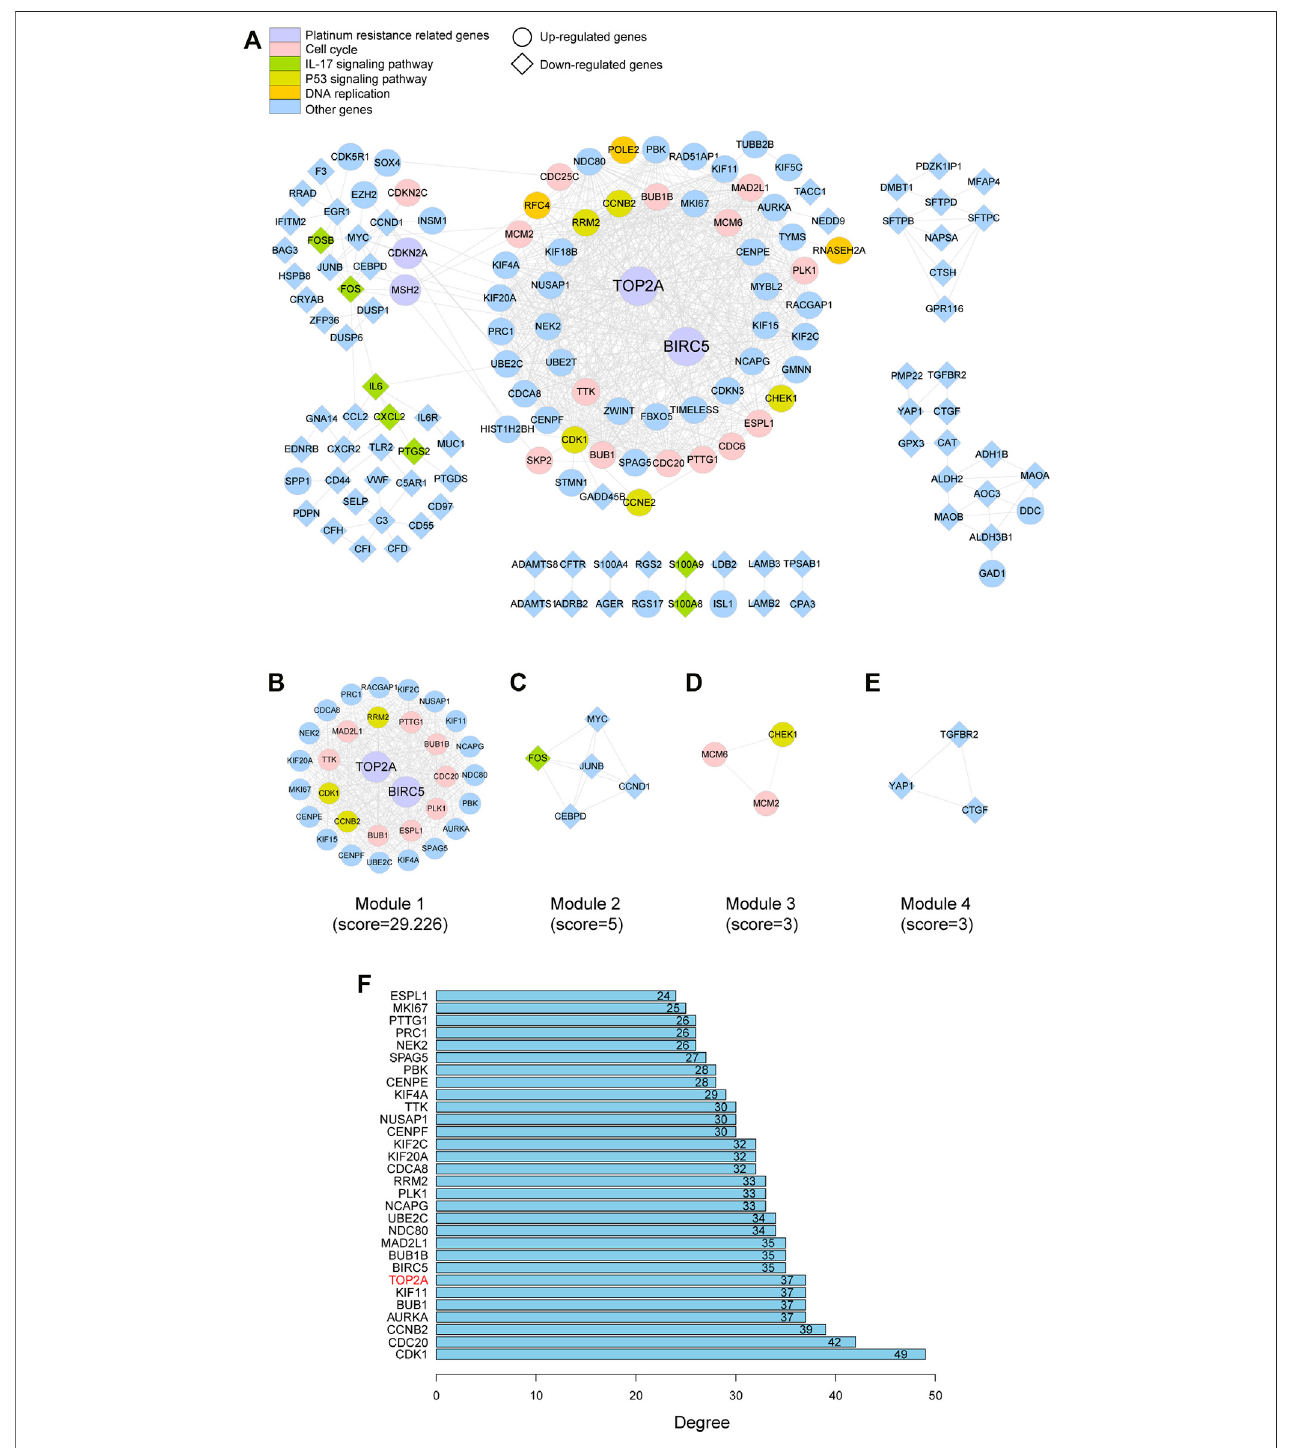
FIGURE 4 | PPI network of the DEGs and hub gene identi fi cation. (A) Visualization of the PPI network of DEGs identi fi ed in samples from GSE datasets. (B – E) Network of four functional clusters that were identi fi ed by MCODE. (F) Top 30 genes with high degree calculated by cytoHubba.